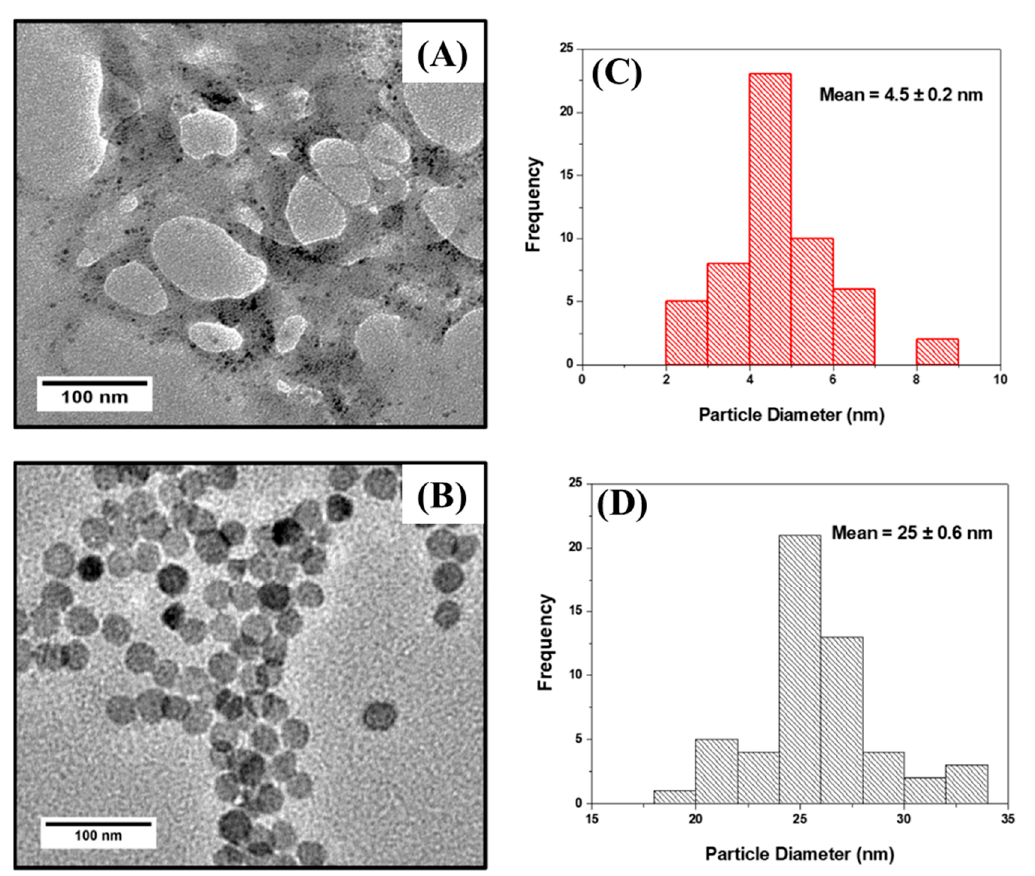
Figure 1. TEM images and particle size distribution of GSH capped ( A , C ) CuS-1 and ( B , D ) CuS-2.